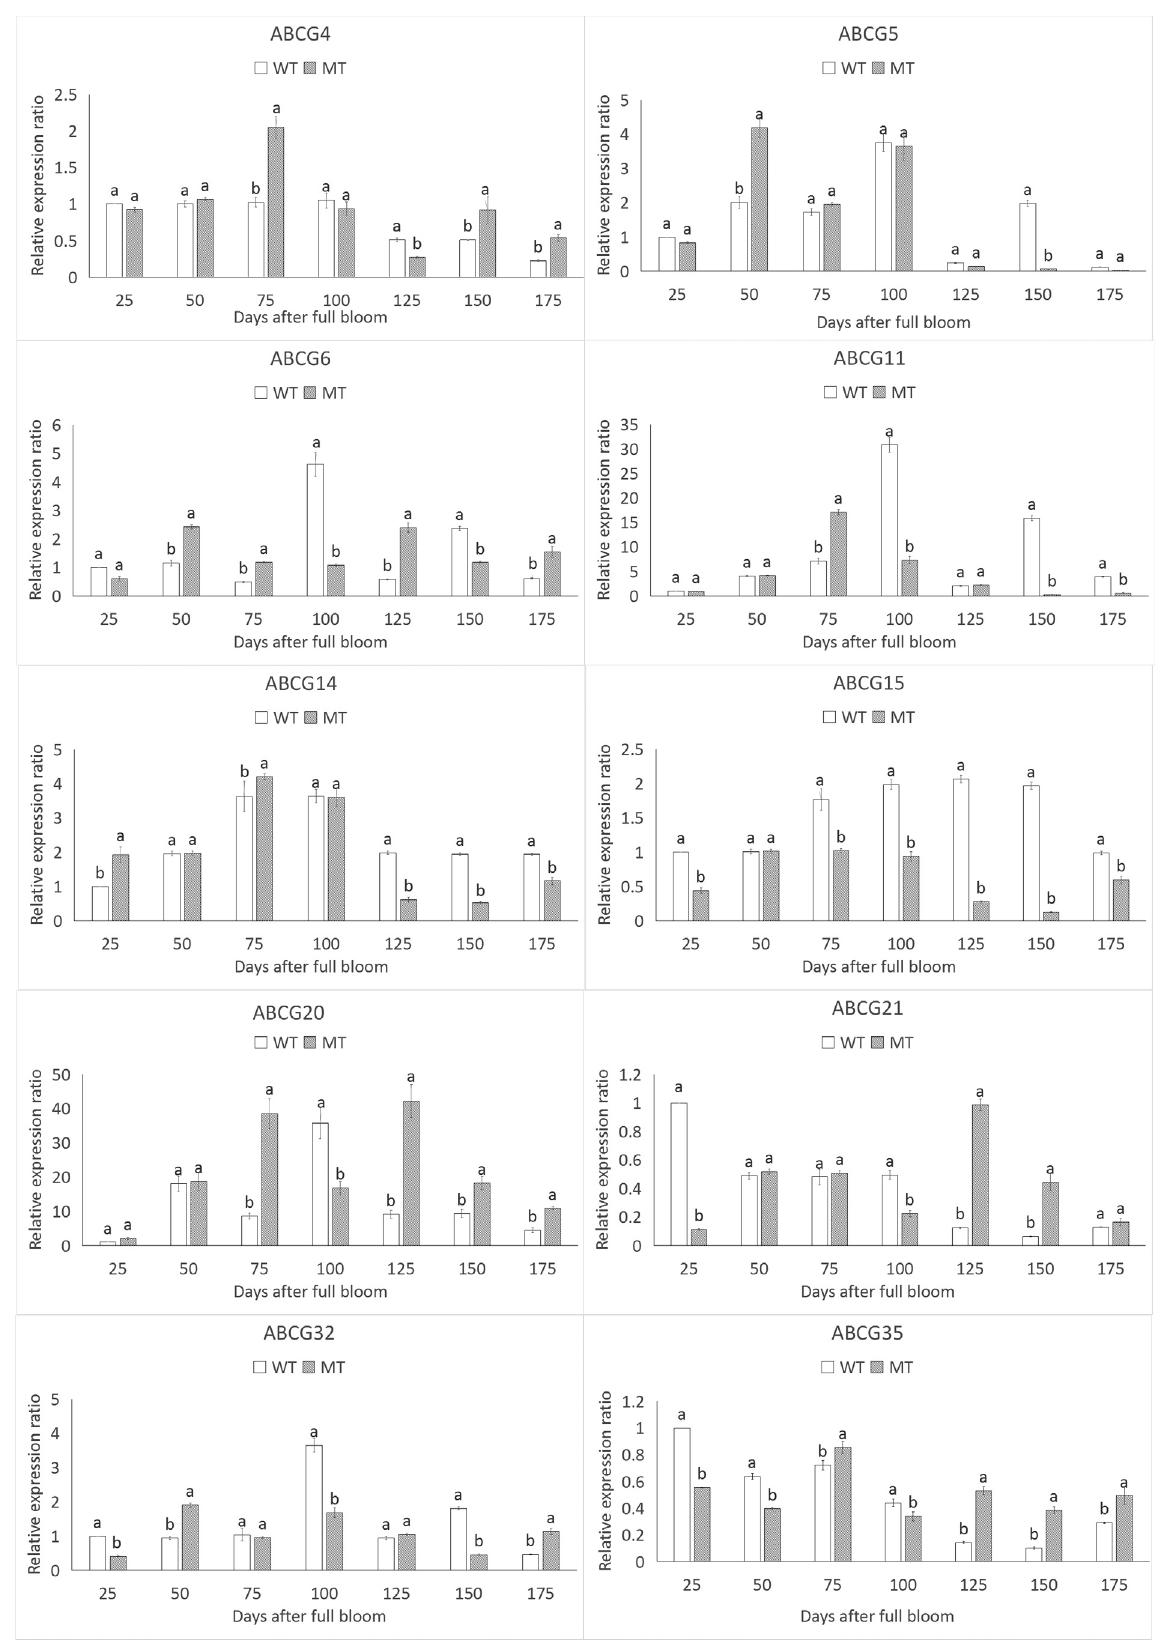
Figure 2 - The relative expression levels of 10 PbABCG genes in the exocarps of ‘Dangshansuli’ and its russet mutant